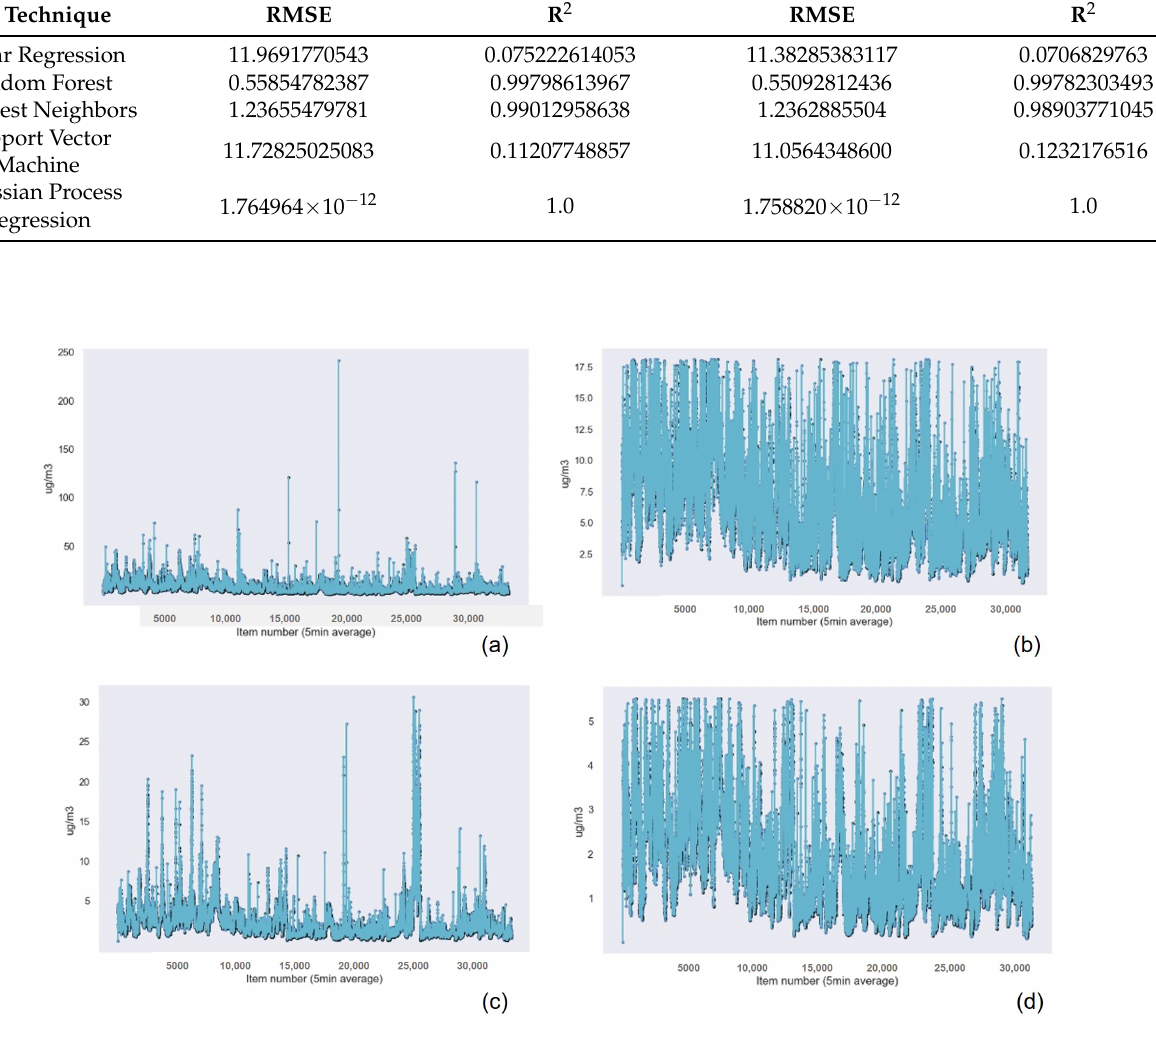
Figure 15. Gaussian Process Regression graphical results for the suspended particulate matter measuring device of ( a ) the PM 2.5 sensor data with outliers, ( b ) the PM 2.5 data without outliers, ( c ) the PM 1 data with outliers, and ( d ) the PM 1 data without